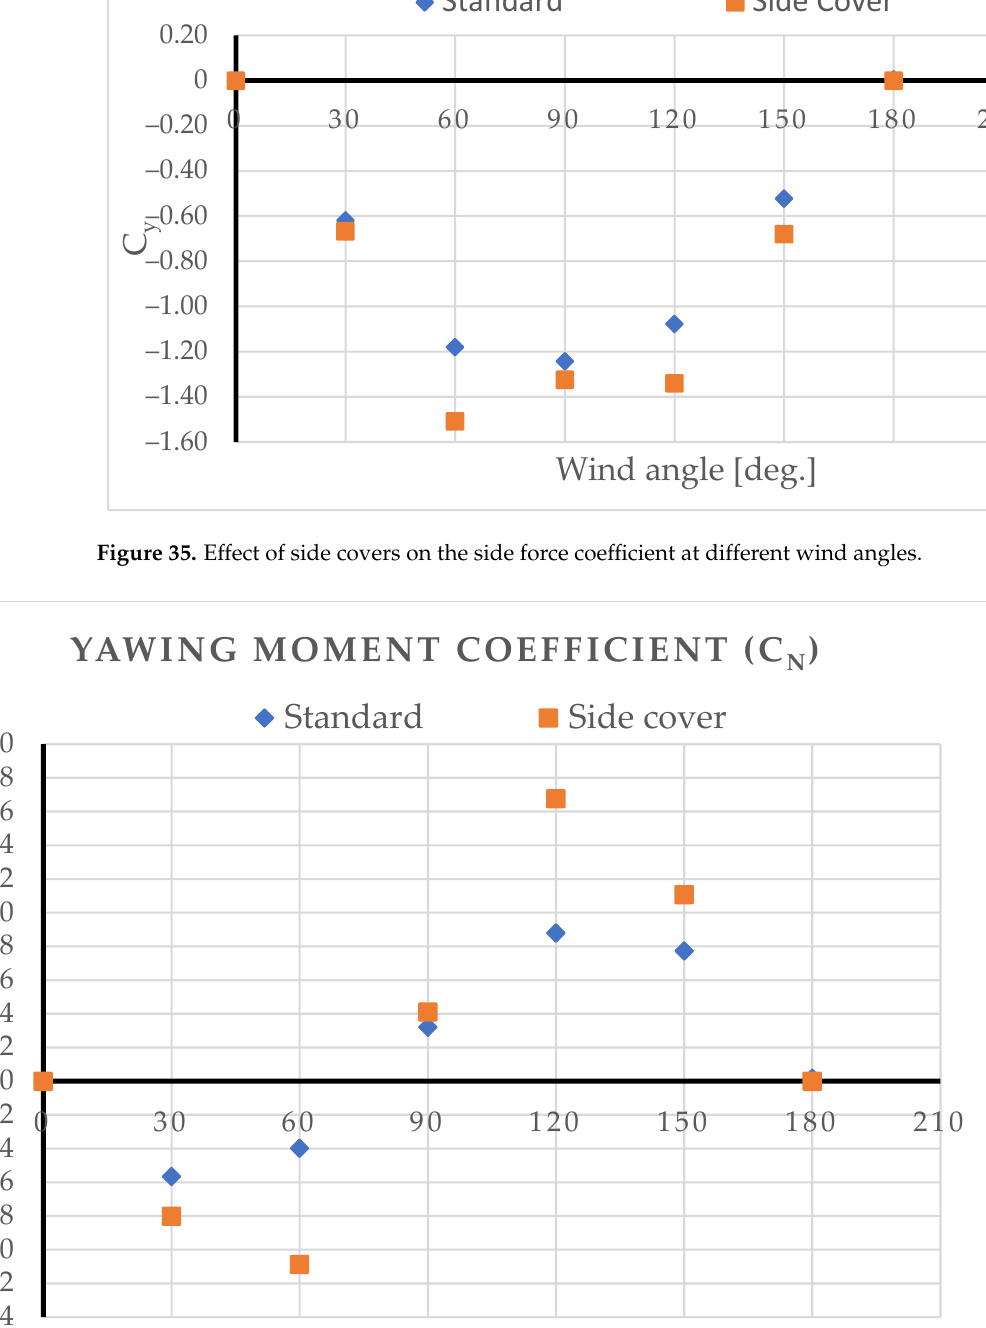
Figure 36. Effect of side covers on the yawing moment coefficient at different wind angles. Table 3. Resistance coefficient and reduction of resistance coefficient at a wind direction of 30 de- grees.